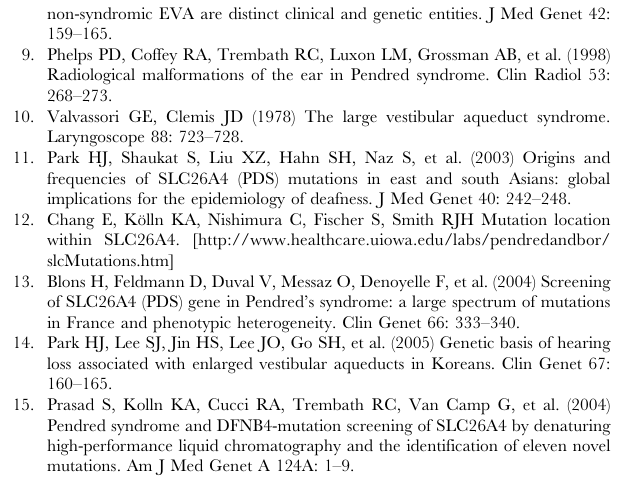
Figure S1 Geographic distribution and the proportion of patients carrying two SLC26A4 mutant alleles in each region studied. NE: not examined (TIF) Figure S2 Examples of CT and MRI images of normal children and children with SLC26A4 mutations. A: CT of temporal bone of a normal child. Arrows show the normal vestibular aquaduct. B: CT of a patient with EVA. Arrows mark the enlarged vestibular aquaduct. C: MRI of child with normal inner ear. Arrows indicate the normal endolymphatic sac. D: MRI of a patient with EVA. Arrows mark the hydrop of endolymphatic sac. (TIF) Figure S3 Representative pure-tone audiograms of children with SLC26A4 mutations. A: c.259G . T/ c.2168A . G. B: c.941C . T/c.1174A . G. C: c.1517T . G/IVS7- 2A . G. D: c.1991C . T/IVS7-2A . G Figure S4 Protein sequences of 13 SLC26A4 orthologs, including: (1) Homo sapiens (NP_000432.1), (2) Nomas-